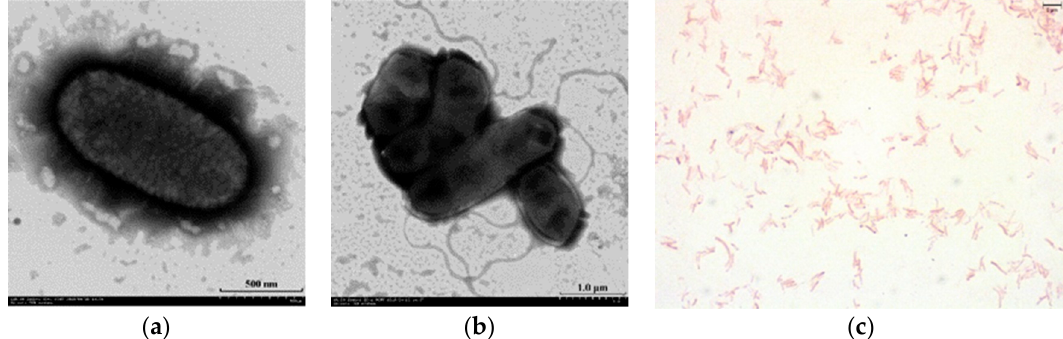
Figure 1. Transmission electron micrograph showing the morphology of strain HR1 and Gram-stain of HR1. Bar: 500 nm for ( a ), 1.0 μ m for ( b ), 5 μ m for ( c ).